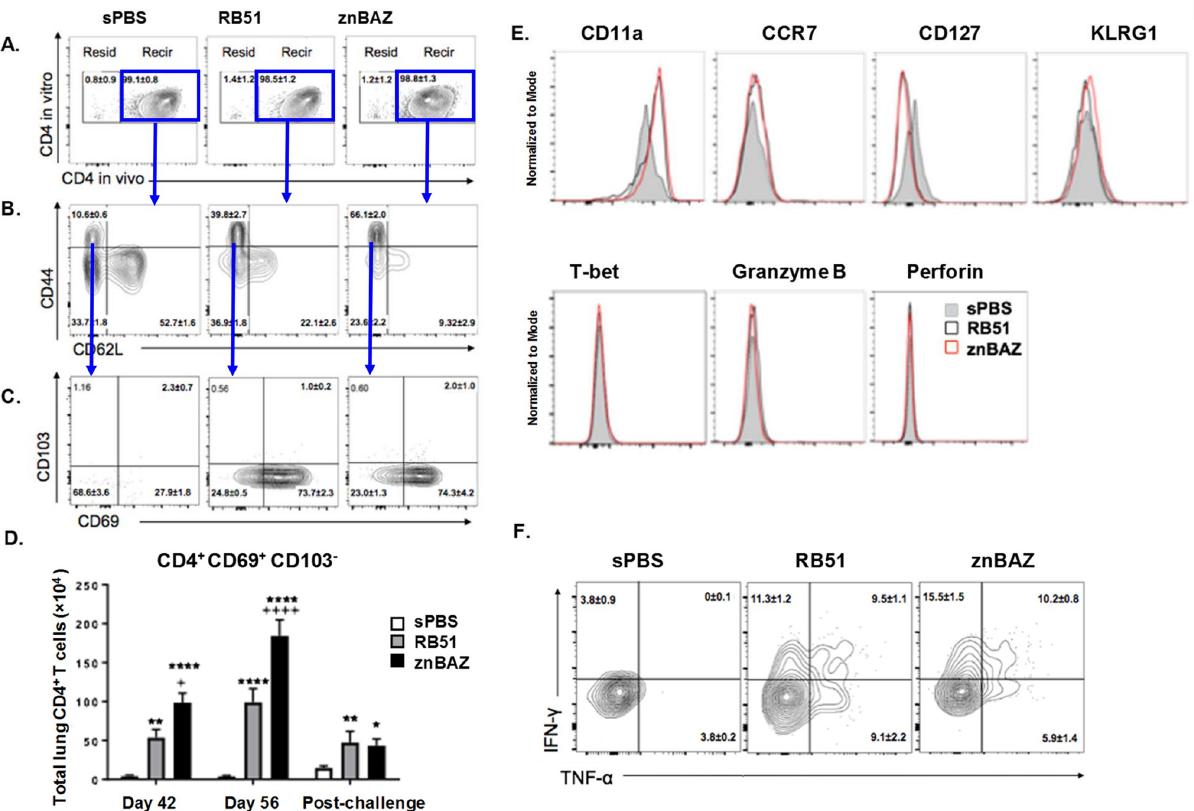
Fig 5. Mucosal znBAZ vaccination enhances the influx of recirculating memory CD44 hi CD69 + CD4 + T cells into the lungs. BALB/c mice were primed and boosted with sPBS, RB51, and znBAZ as described in (Fig 1A). Pre- or post-wt B . abortus 2308 challenge, mice were analyzed for the expression of resident (Resid) and recirculating (Recir) memory CD4 + T cell subsets on days 42 and 56 (pre-challenge), as well as on day 84 (post- challenge). (A) Flow cytometric analysis of lung CD4 + T cells in vivo labeled on day 56. (B) FACS plots show the percentage of cells expressing CD62L and CD44, and (C) CD69 and CD103. (D) Total numbers of CD103 - CD69 + memory CD4 + T cells from the lungs at various time points are depicted. The data depict n = 12 mice per group showing the mean ± SEM of three independent experiments. The differences were determined when compared to sPBS-dosed mice ( ���� P < 0.0001, ��� P < 0.001, �� P < 0.01, � P < 0.05), or compared to RB51-vaccinated mice ( ++++ P < 0.0001, +++ P < 0.001, ++ P < 0.01, + P < 0.05). The difference among time points were determined when compared to day 42 ( †††† P < 0.0001, ††† P < 0.001, †† P < 0.01, † P < 0.05), or compared to day 56 ( ‡‡‡‡ P < 0.0001, ‡‡‡ P < 0.001, ‡‡ P < 0.01, ‡ P < 0.05). Analysis of variance with Two-way ANOVA Tukey’s multiple comparisons test was performed. (E) Expression of CD11a, CCR7, CD127, KLRG1, T-bet, granzyme B, and perforin by memory CD103 - CD69 + CD4 + T cells from the lungs on day 56. (F) IFN- γ and TNF- α production by memory CD103 - CD69 + CD4 + T cells from the lungs on day